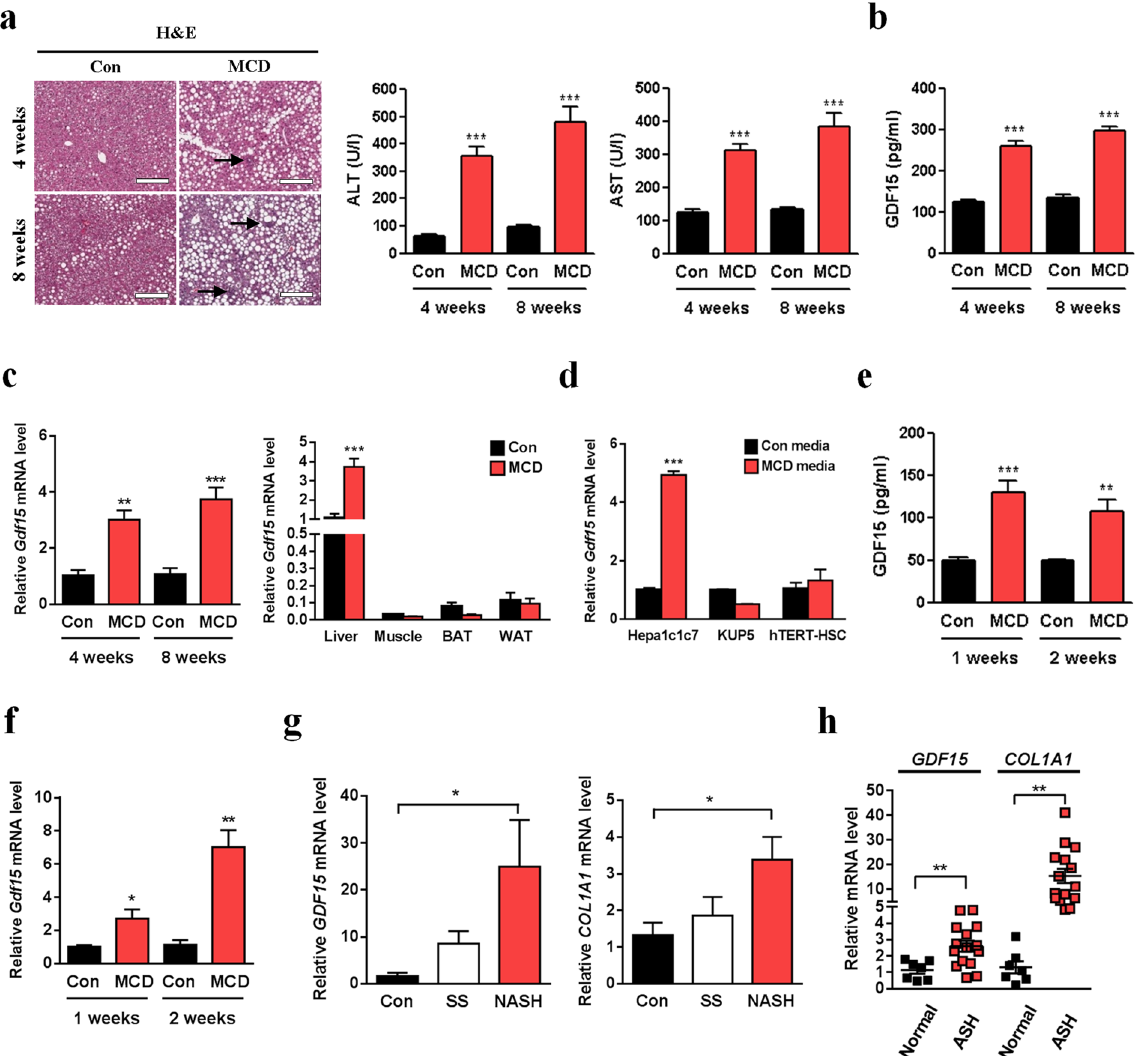
Figure 1. GDF15 is induced in the livers of MCD diet-fed mice and human NASH subjects. ( a ) Liver H&E staining and serum ALT/AST levels (n = 8) in C57BL/6 mice fed MCD diet for 4 or 8 weeks. Scale bar, 200 μ m. Arrows indicate inflammatory loci. ( b ) Serum GDF15 level in C57BL/6 mice fed MCD diet for 4 or 8 weeks (n = 6–8). ( c ) Relative hepatic Gdf15 mRNA level in C57BL/6 mice fed MCD diet for 4 or 8 weeks (left panel, n = 3–5), and relative Gdf15 mRNA level in various metabolic organs in mice fed MCD diet for 8 weeks (right panel, n = 5). ( d ) Relative Gdf15 mRNA levels in Hepa1c1c7, KUP5 or hTERT-HSC cell lines incubated in MCD media for 18 h (n = 5). ( e,f ) Serum GDF15 ( e , n = 5) and relative hepatic Gdf15 mRNA levels ( f , n = 4–5) in mice fed MCD diet for 1 or 2 weeks. ( g ) Relative GDF15 and COL1A1 mRNA levels in the livers from control human subjects and subjects with simple steatosis (SS) or NASH (n = 6). ( h ) Relative GDF15 and COL1A1 mRNA levels in the liver tissue from subjects with alcoholic steatohepatitis (ASH, GSE28619) (control, n = 7; ASH, n = 15). Data are means ± SEM. * p < 0.05, ** p < 0.01, *** p <